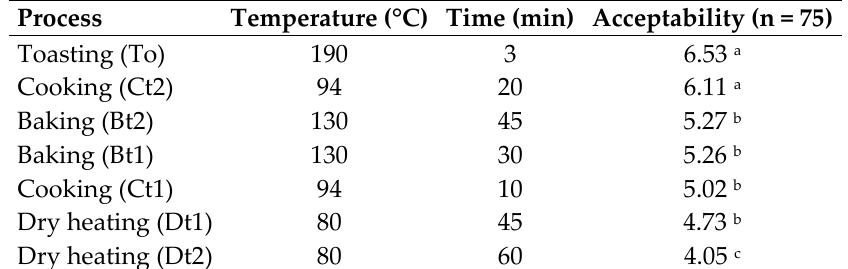
Figure 1. Representation of F1–F2 factors of the principal component analysis applied to the data of the first sensorial analysis—process selection. ( a ) Variables: sensory attributes ( ∆ ), supplementary variable: acceptability ( ● ). ( b ) Samples ( □ ), supplementary variable: acceptability ( ● ). Table 1. Conditions and response of acceptability of the different preparation